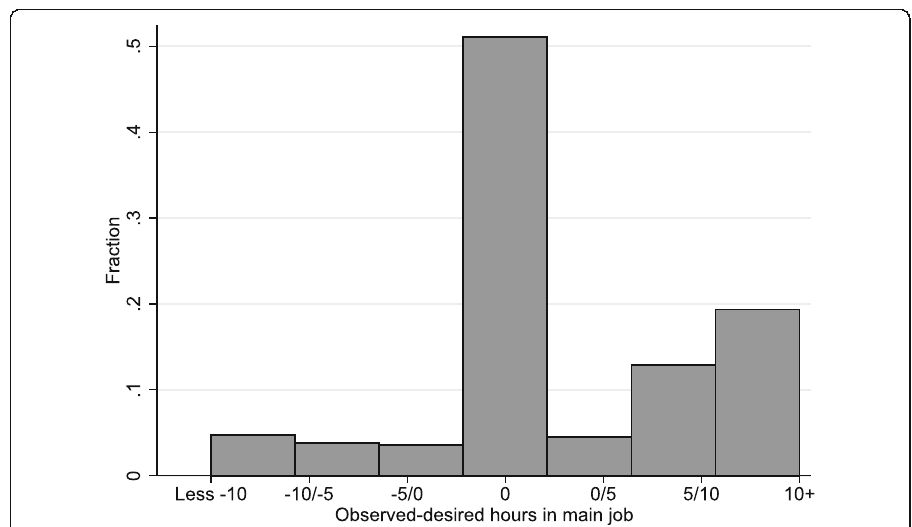
Fig. 4 Distribution of difference between observed and desired hours for workers. Notes: 527